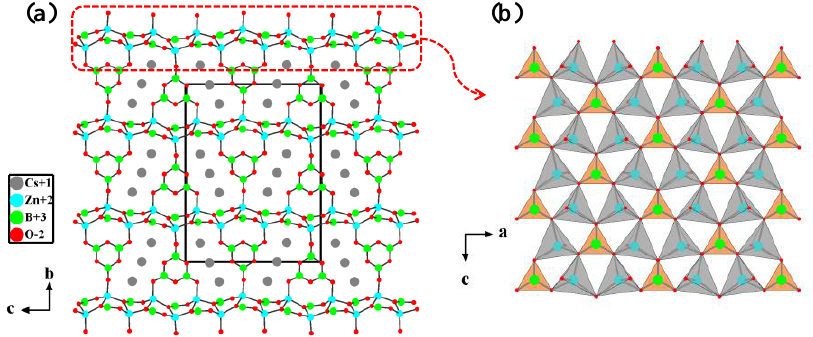
Figure 3. ( a ) The crystal structure of Cs 3 Zn 6 B 9 O 21 viewed along the a -axis; ( b ) the 2 ∞ [Zn 2 BO 3 O 2 ] layer composed of [ZnO 4 ] 6 − tetrahedra and nearly coplanar [BO 3 ] 3 − triangles. Adapted with permission from Ref. [45,46]. Copyright (2014) American Chemical Society.